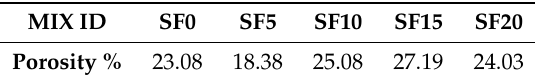
Figure 10. CPB pore structure analysis of di ff erent groups: ( a ) SF0; ( b ) SF5; ( c ) SF10; ( d ) SF15; and ( e ) SF20. Table 3. Porosity of the CPB